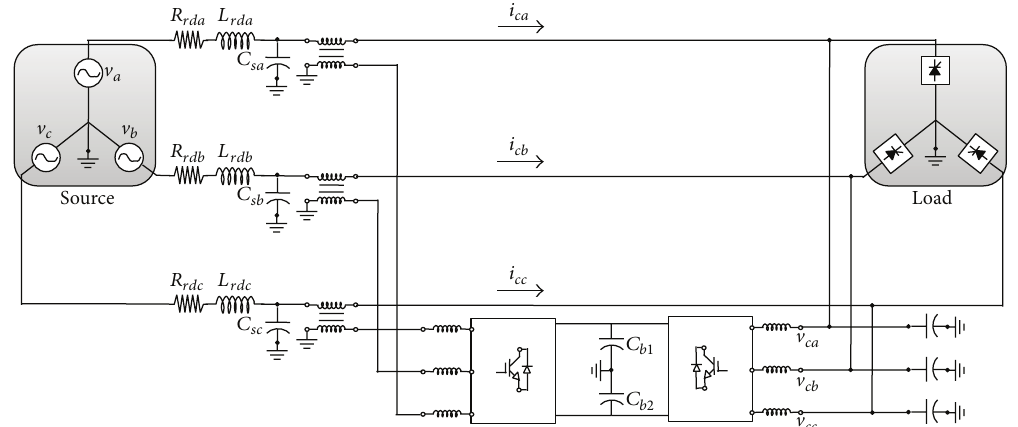
Figure 3: Circuit scheme of the UPQC.